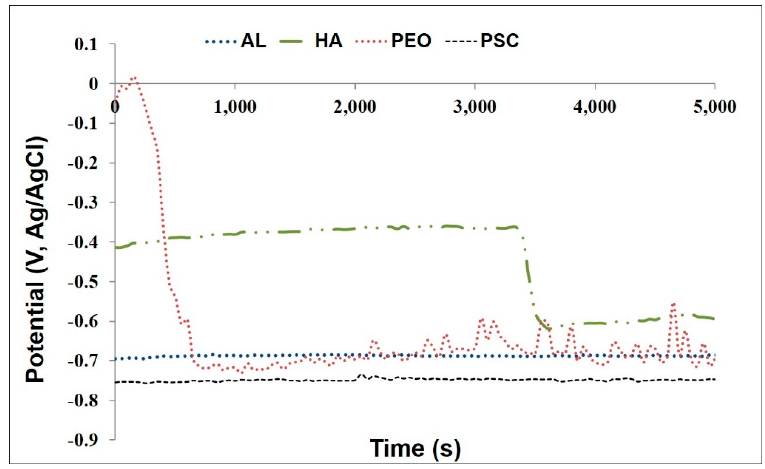
Figure 7. OCP measurements of the coating materials for 5000 s in Ag/AgCl reference electrode.